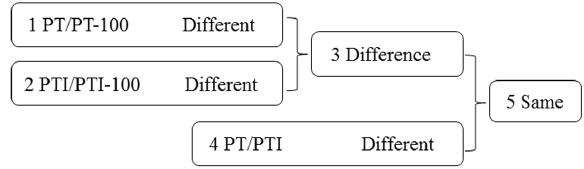
Figure 1. Comparison schemes of the four samples. PT represents the healthy wild-type sample of P. tomentosa , PTI represents the sample of phytoplasma infected PT. PT-100 represents the sample of 100 mg L − 1 rifampicin treated PT, PTI-100 represents the sample of 100 mg L − 1 rifampicin treated PTI. Different represents differentially expressed genes/long non-coding RNAs (lncRNAs). Difference represents the union of two groups, except their intersection. Same represents the intersection of two